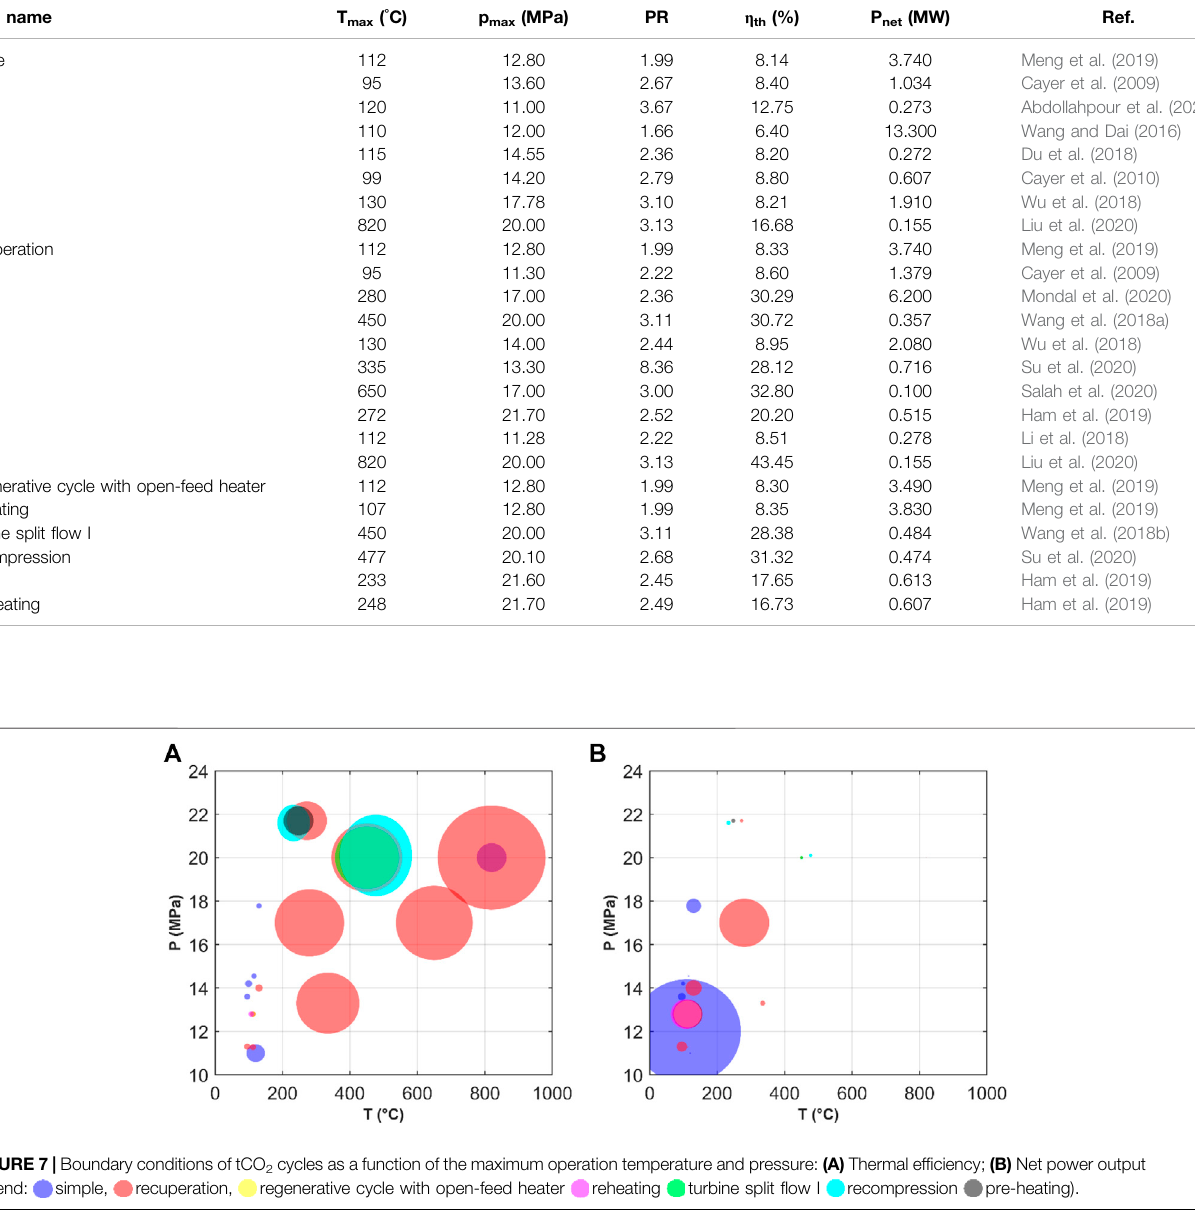
TABLE 6 | Boundary conditions of tCO 2 cycles.